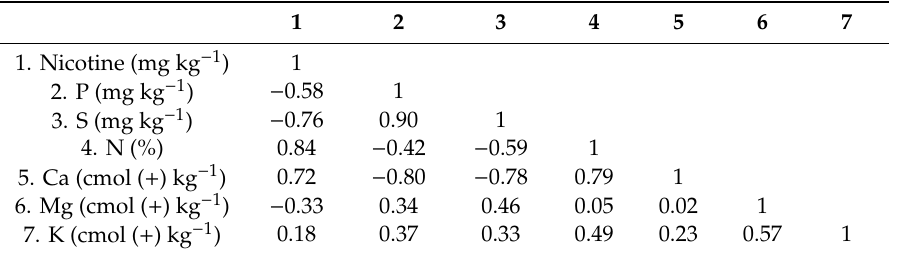
Table 4. Correlations between nicotine and the measured macronutrients in